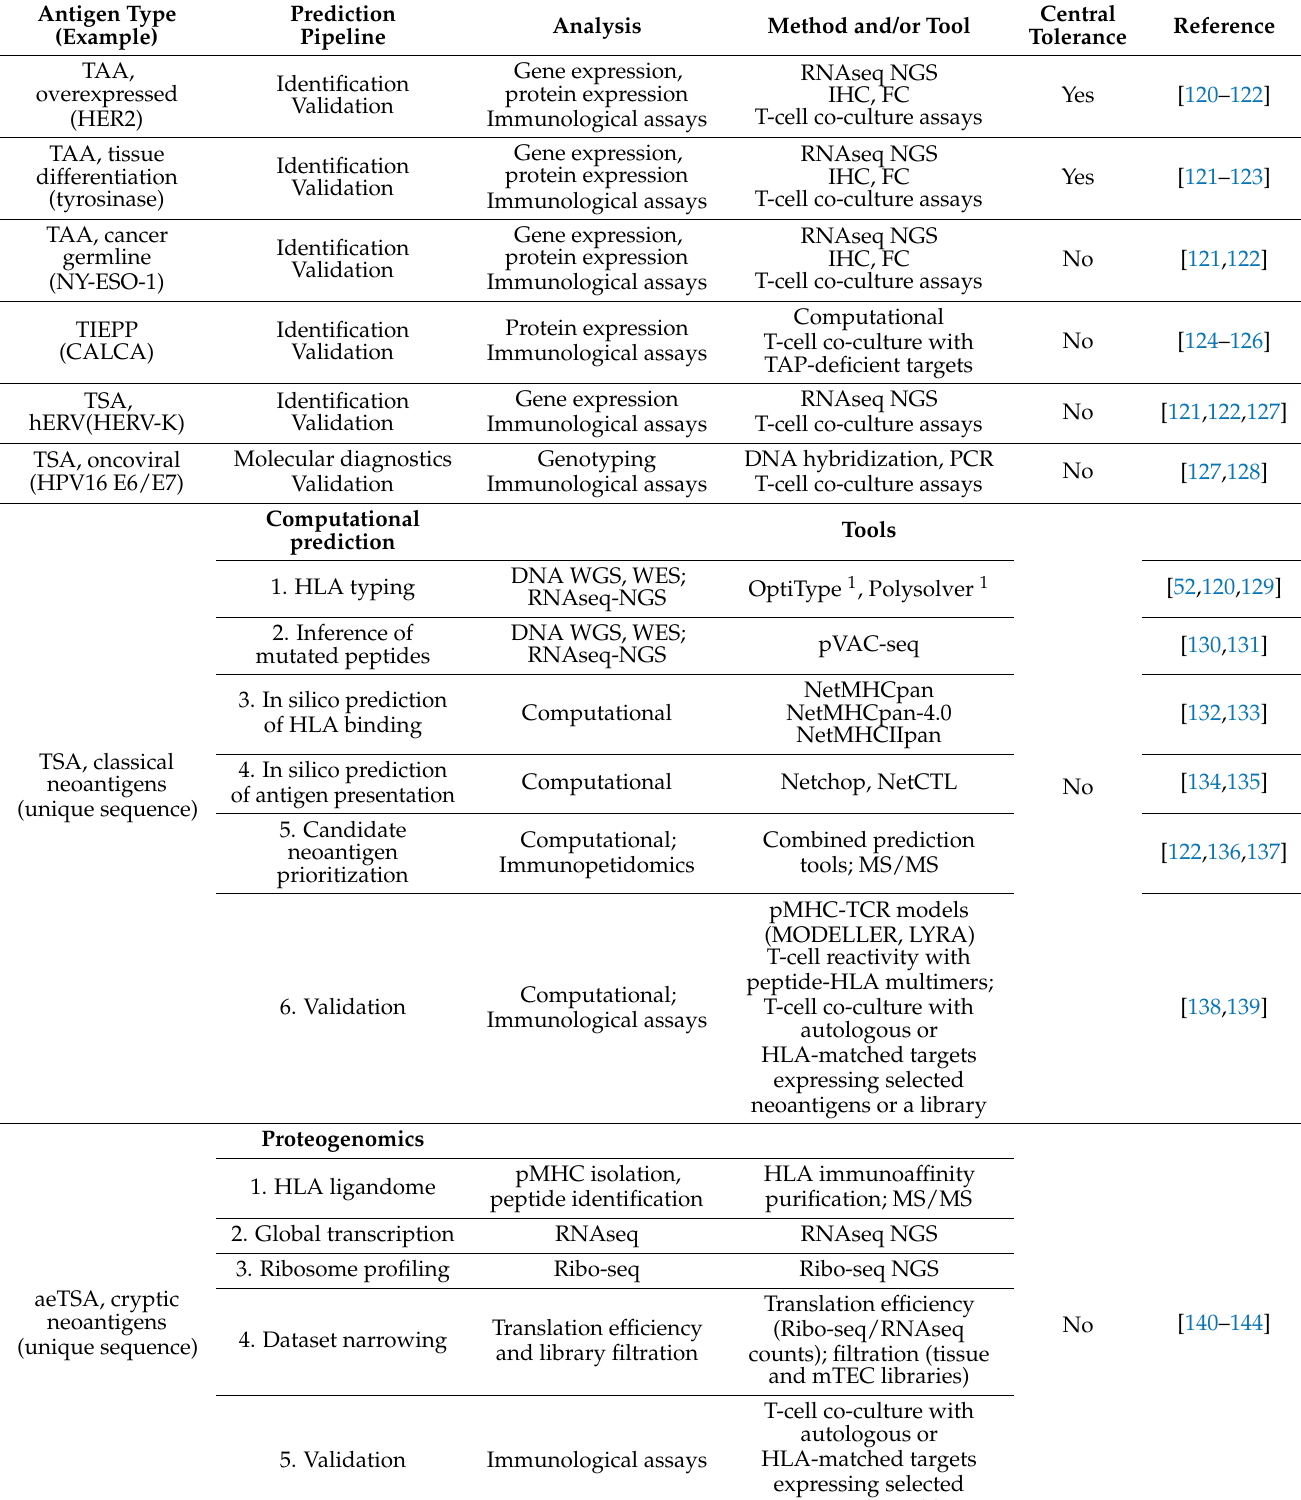
Table 1. Types of tumor antigens and methods of analysis and/or